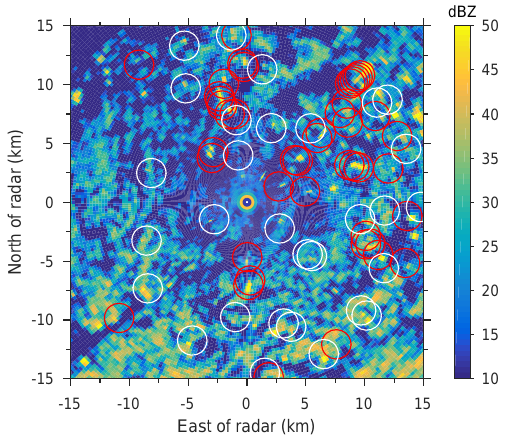
Figure 1. Average total (unfiltered) reflectivity data from the radar Vara for September 2016. Red circles are centred on locations of known, nearby wind turbines while white circles mark the positions of known